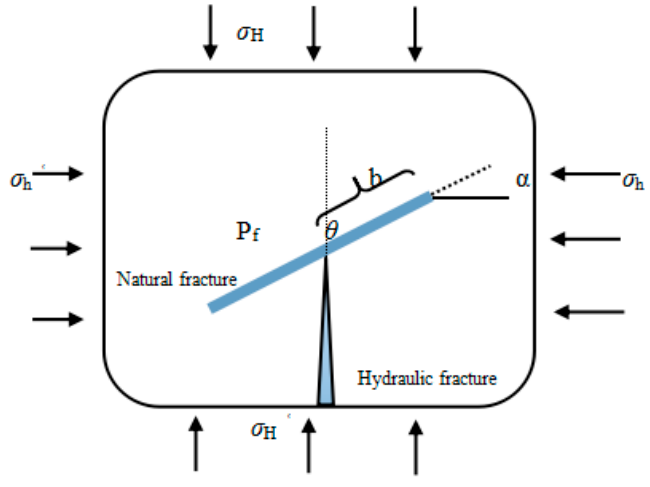
Figure 5. The illustration of stress on natural fracture unit.